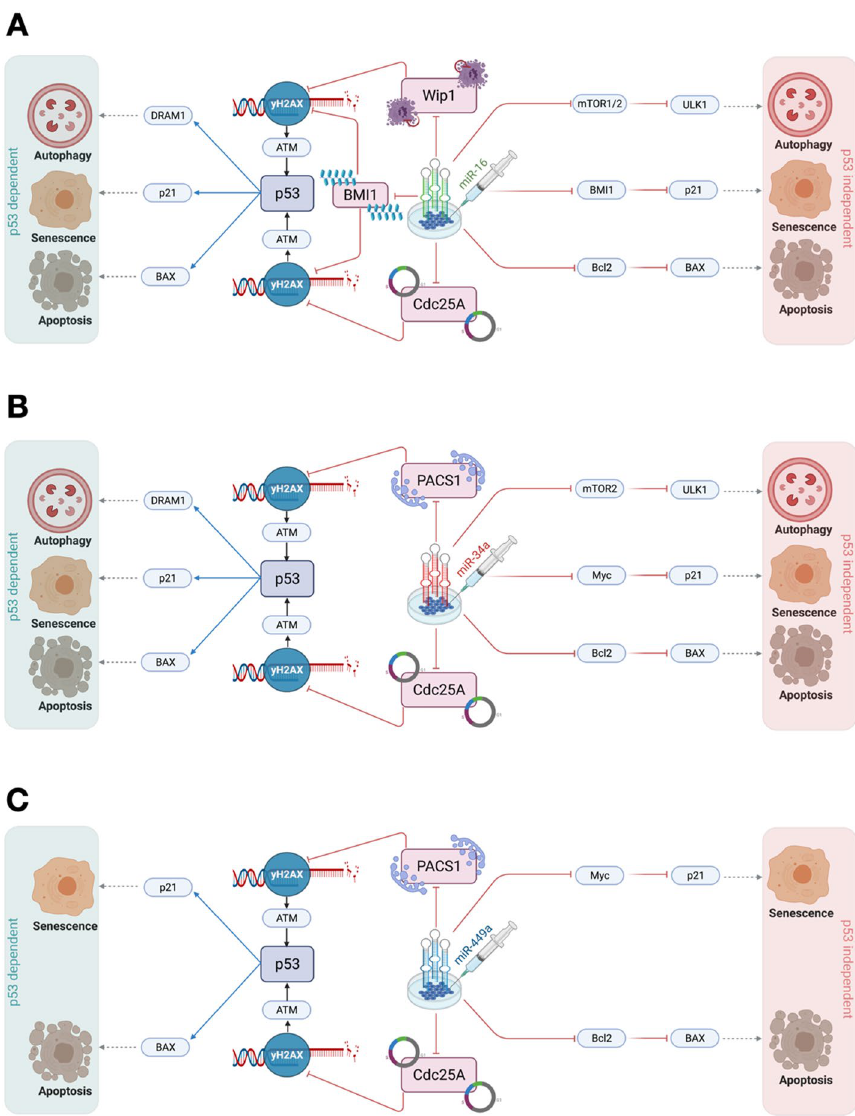
Figure 7. Comprehensive molecular mechanisms of transfection of miRNAs on tumor growth and proliferation in HeLa cells. ( A ) Transfection of miR-16-induced DNA damage in cells by targeting Wip1 6 and Cdc25A 3 . Once DNA damage is triggered in cells it may regulate p53-dependent or independent molecular mechanisms at the functional G1/S checkpoint 20 . miR-16 directly targets mTOR1/2 induced autophagic cell death 7,60 . Whereas miR-16 controls the senescent phenotype by targeting BMI1, which regulates p21 expression 61 . Whereas, miR-16 regulates apoptotic cell death by targeting Bcl2, which triggers BAX/Caspase expression 62 . On the other hand, transfection of miR-16 regulates cell fate through the p53 46 . miR- 16 accelerated the p53 pathway and then, p53 induces autophagic cell death through DRAM1 63 . Senescence by induction of p21 20 while apoptotic through induction of BAX/Caspase 20 . ( B ) Transfection of miR-34-induced DNA damage in cells by targeting PACS1 and Cdc25A 2,64 . Once DNA damage is triggered in cells it may control p53-dependent or independent molecular mechanisms at the functional G1/S checkpoint. miR-34 directly targets mTOR2 induced autophagic cell death 8 . Whereas miR-34a regulates the senescent phenotype by targeting Myc 65 , which regulates p21 expression. Whereas, miR-34a rules apoptotic cell death by targeting Bcl2 66 , which triggers BAX/Caspase expression. On the other hand, transfection of miR-34 coordinates cell fate through the p53 34 . miR-34 stimulated the p53 pathway and then, p53 induces autophagic cell death through DRAM1 63 . Senescence by induction of p21 20 while apoptotic through the introduction of BAX/Caspase 20 . ( C ) Transfection of miR-449a-induced DNA damage in cells by targeting PACS1 and Cdc25A 2,45 . Once DNA damage is generated in cells it may control p53-dependent or independent molecular mechanisms at the functional G1/S checkpoint 2 . miR-449a controls the senescent phenotype by targeting Myc 67 , which modulates p21 expression. Whereas, miR-449a rules apoptotic cell death by targeting Bcl2 68 , which triggers BAX/Caspase expression. On the other hand, transfection of miR-449a regulates cell fate through the p53 2 . miR-449a activated the p53 pathway and then, p53 induces senescence by the activation of p21 20 , while triggers the apoptosis by the activation of BAX/Caspase 20 . On the right, p53-independent molecular mechanisms of cell fate decisions such as autophagy, senescence, and apoptosis. On the left, p53-dependent molecular mechanisms of cell fate determination (autophagy, senescence, and apoptosis). Red-hammer head arrows represent inhibitions, while blue arrows indicate activation,